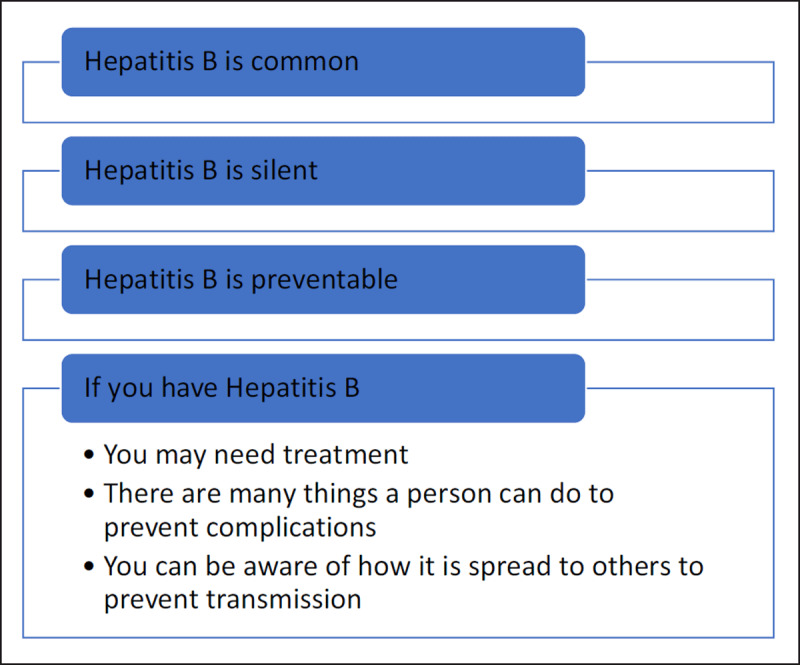
Workshop Messaging.